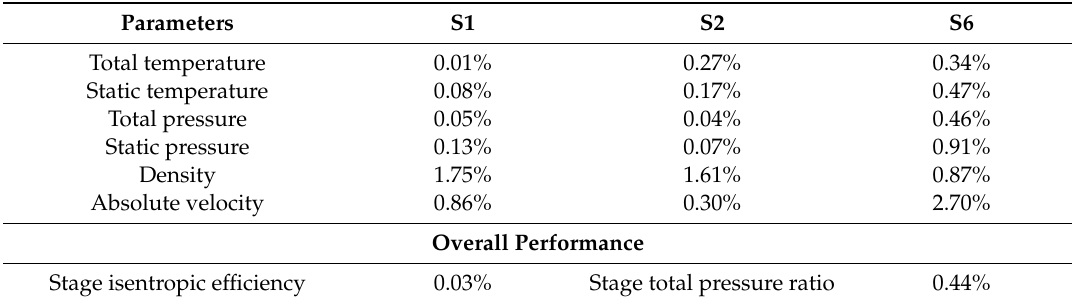
Table 7. The relative errors of the preliminary design results against the numerical simulation solutions for the optimal compressor